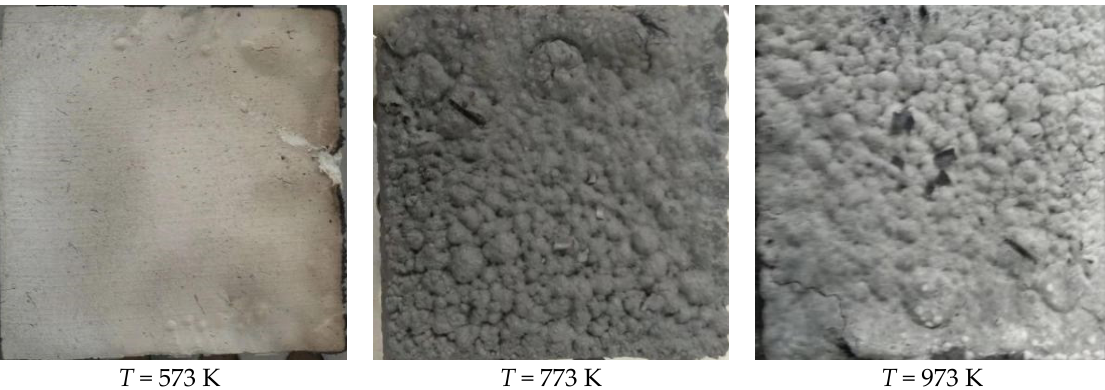
Figure 5. State of the intumescent coating at different temperatures.